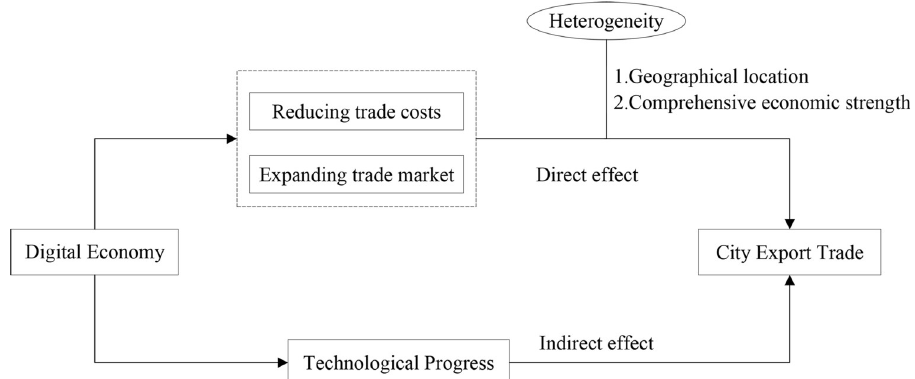
Fig 1. Pathways for the influence of the digital economy on city export